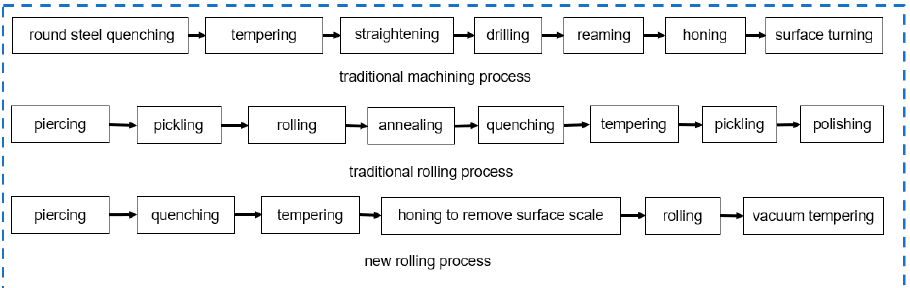
Figure 10. Flow chart of three preparation processes.